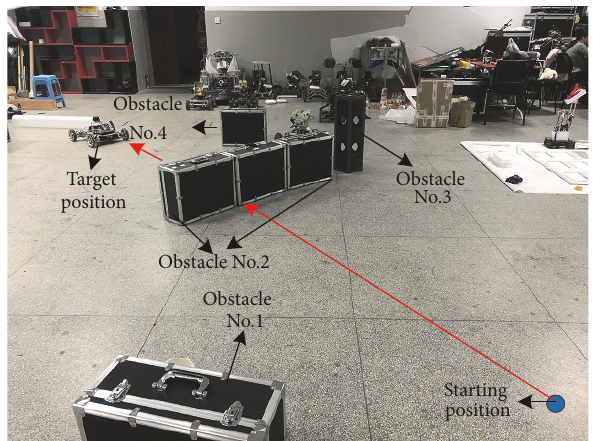
Figure 9: The actual layout of the unknown environment.